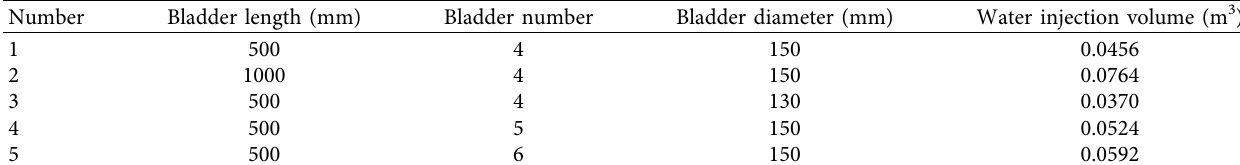
Figure 5: The experimental process. Table 3: Water injection calculating volume of the multibladder-type inflatable